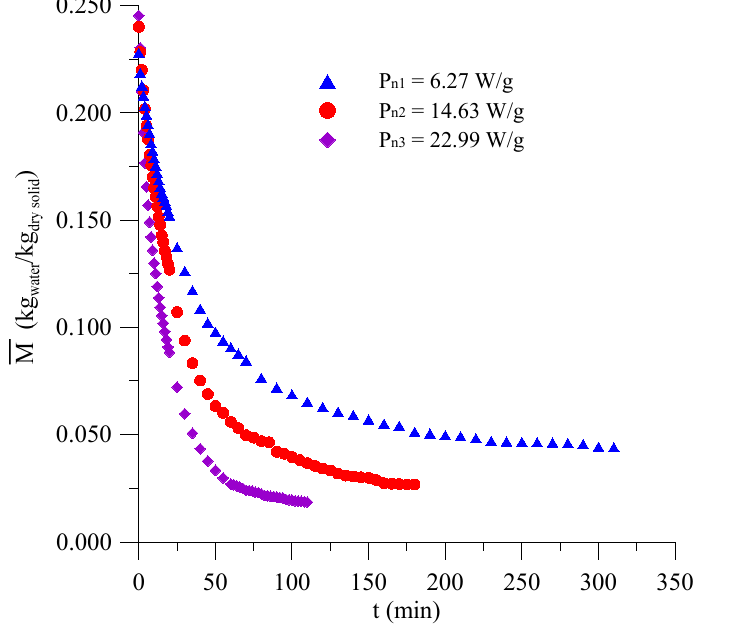
Figure 3. Effect of the supplied microwave power on the average moisture content of rice grains during the drying